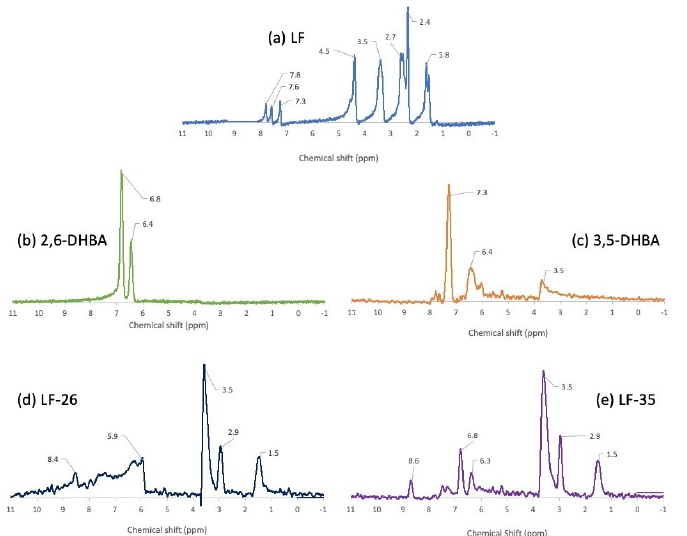
Figure 6. ( a ) 1 H-NMR spectra of levofloxacin (LF); ( b ) 2,6-dihydroxybenzoic acid (2,6-DHBA); ( c ) 3,5-dihydroxybenzoic acid (3,5-DHBA); ( d ) levofloxacin-2,6-dihydroxybenzoic acid (LF-26); ( e ) levofloxacin-3,5-dihydroxybenzoic acid (LF-35) in deuterium (D 2 O).